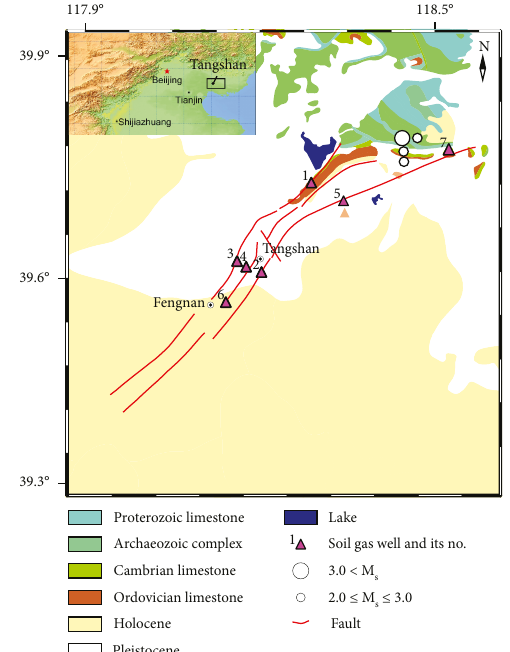
Figure 12: Locations of earthquakes in the Tangshan fault zone, August 5 – 19, 2018.